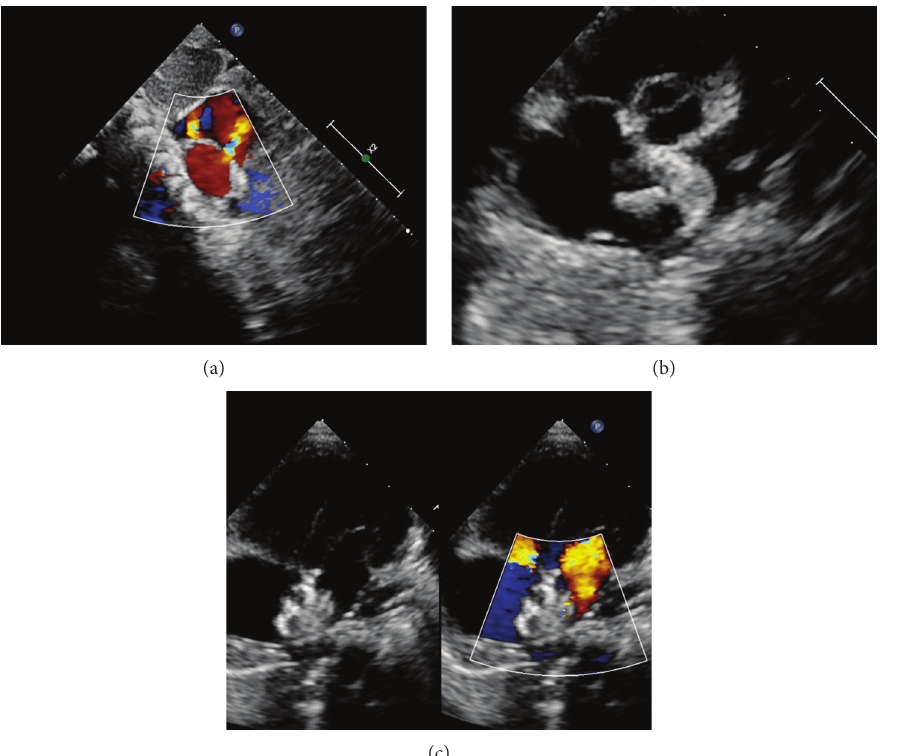
Figure 3: Percutaneous closure of multiple ASDs under TTE guidance. (a) Multiple ASDs image as displayed in subcostal view. (b) The left disc was released (parasternal short-axis view). (c) The ASDs were closed (four-chamber